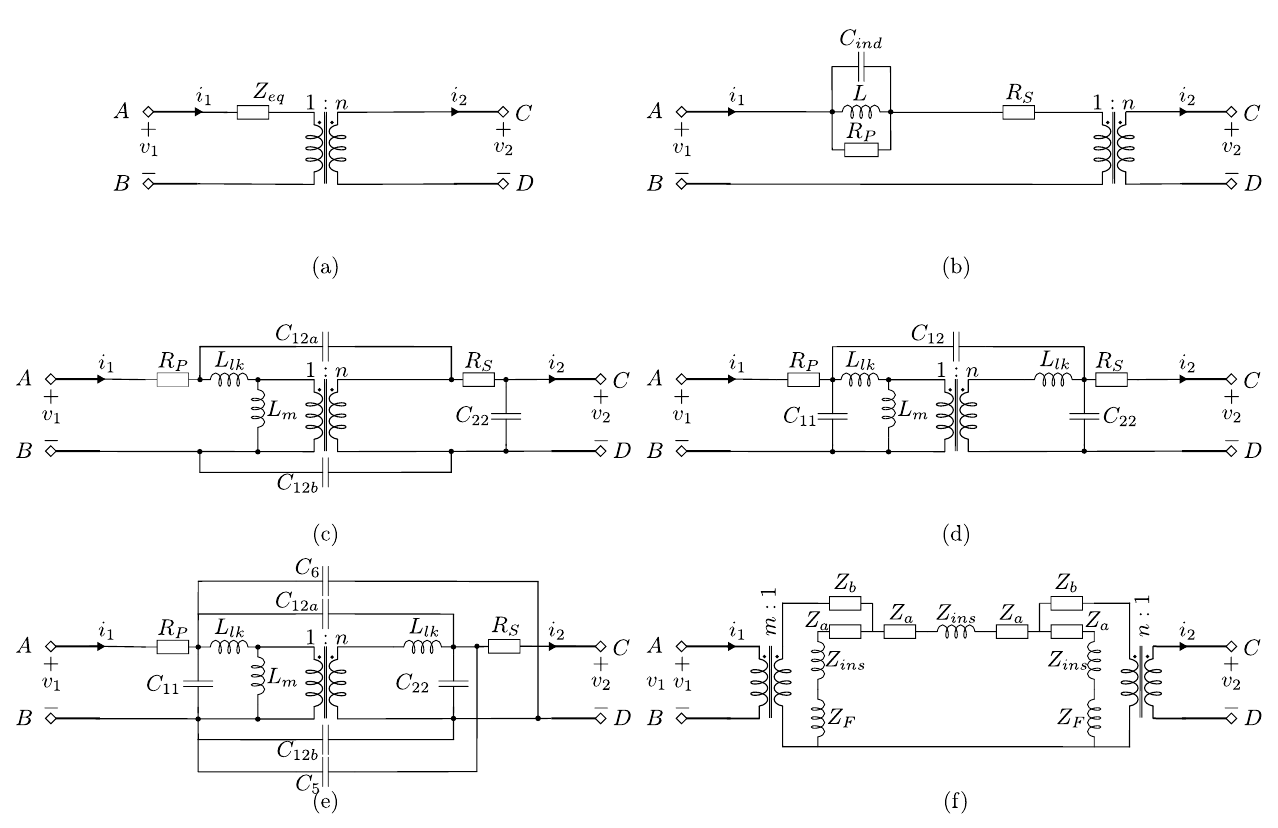
Figure 1. Transformer modeling overview. ( a ) Equivalent circuit with one equivalent AC resistance. ( b ) Equivalent circuit of the model proposed by [7]. ( c ) Equivalent circuit of the model proposed by [8]. ( d ) Equivalent circuit of the lumped model proposed by [9]. ( e ) Equivalent circuit of the six-capacitor model [10]. ( f ) Equivalent circuit of the lumped model proposed by